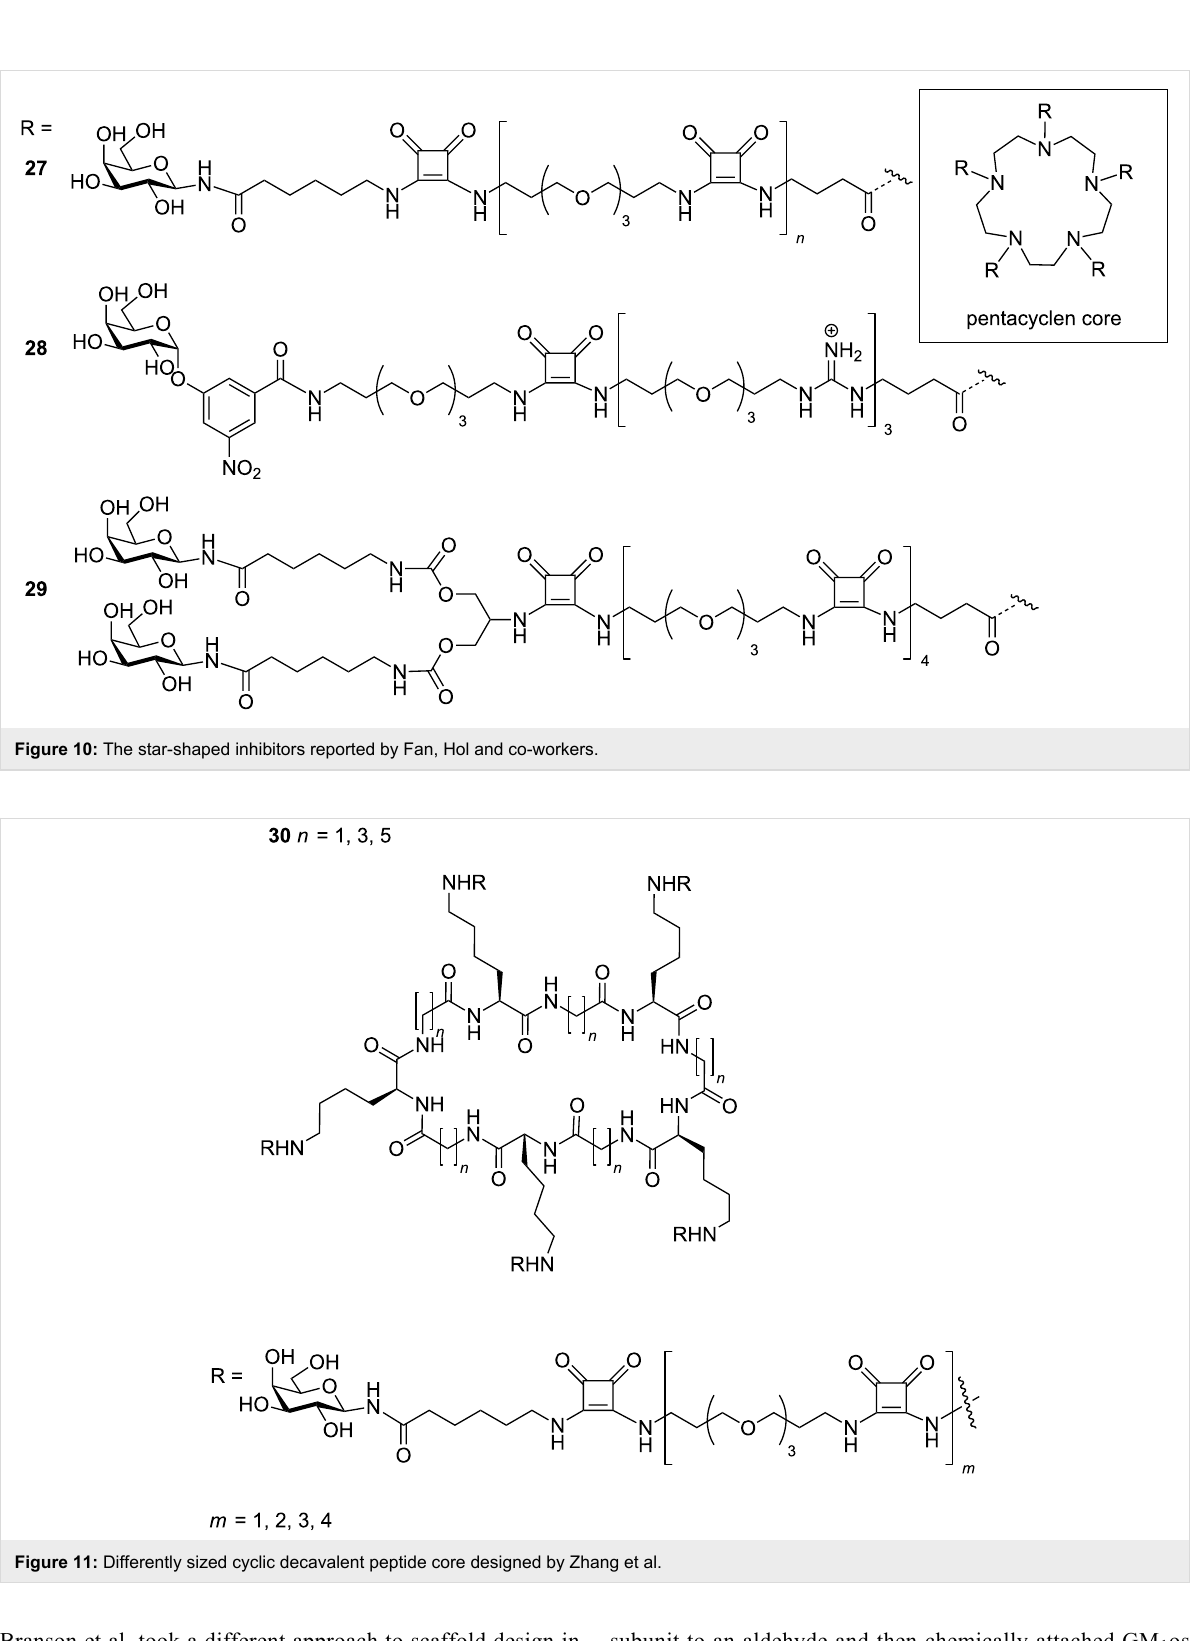
Branson et al. took a different approach to scaffold design in which they made a non-binding mutant of the target CTB pro- tein [66], oxidised the N-terminal threonine residue of each